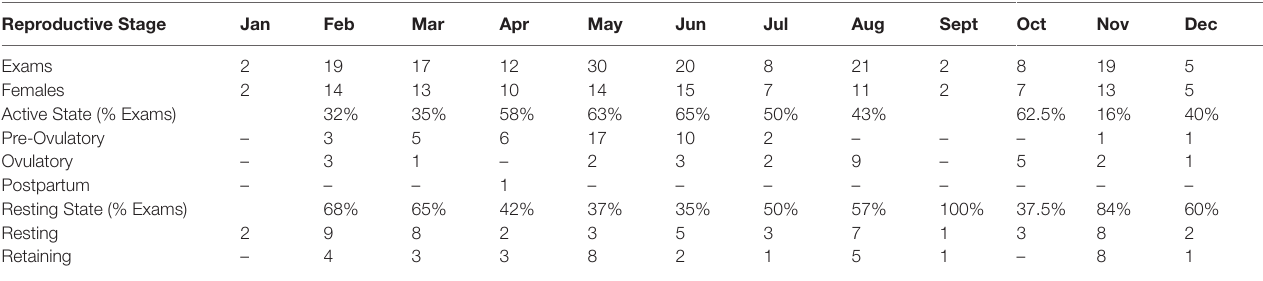
TABLE 5 | Aquarium sand tiger shark Carcharias taurus reproductive stages by month. Reproductive